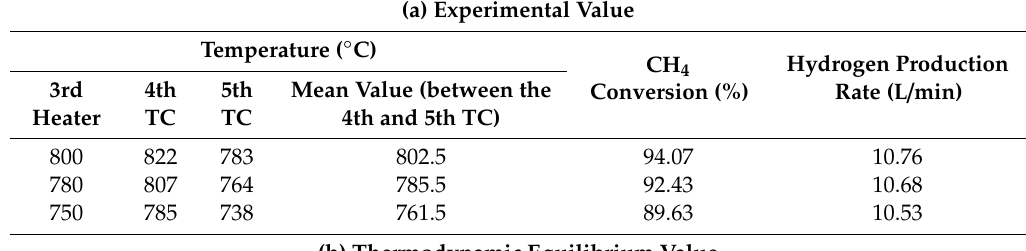
Figure 3. Temperature gradient along the catalyst bed depending on the third heater temperature (catalytic layer: 93 cm length, 96 g catalyst weight, 1386 g dilution agent weight, physical mixing). Schematic diagram of the reactor with the thermocouple (TC) positions (yellow bars) shown on the right-hand side.